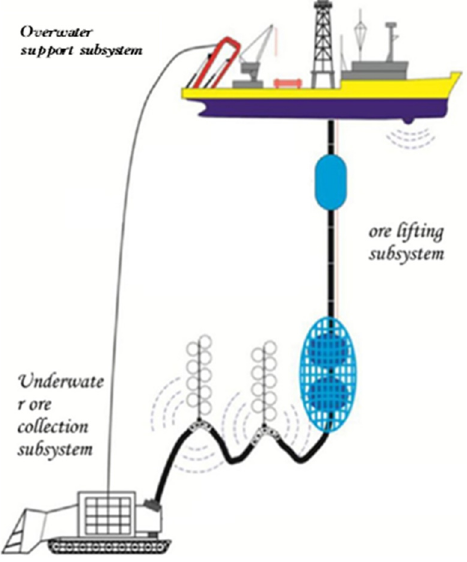
Figure 4. The overall layout of deep-sea hydraulic mining system.